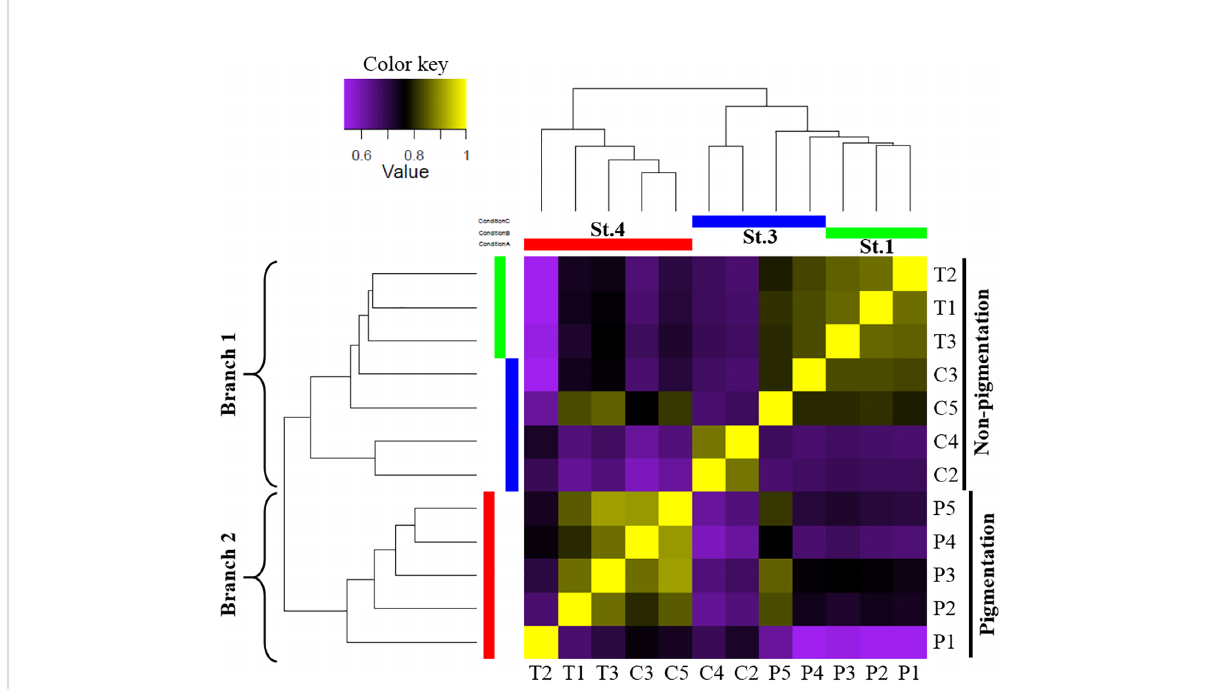
FIGURE 3 Global gene expression patterns in different ANG stages. Correlation heatmap using the Pearson correlation coef fi cient as distance measure result. Heatmap indicates that the early transmission phase (stage 1) and middle colonization phase (stage 3) were grouped in branch 1, and the late pigmentation phase (stage 4) was alone in branch 2. The expression patterns are depicted according to the color scale. St, stage; T, transmission phase; C, colonization phase; P, pigmentation